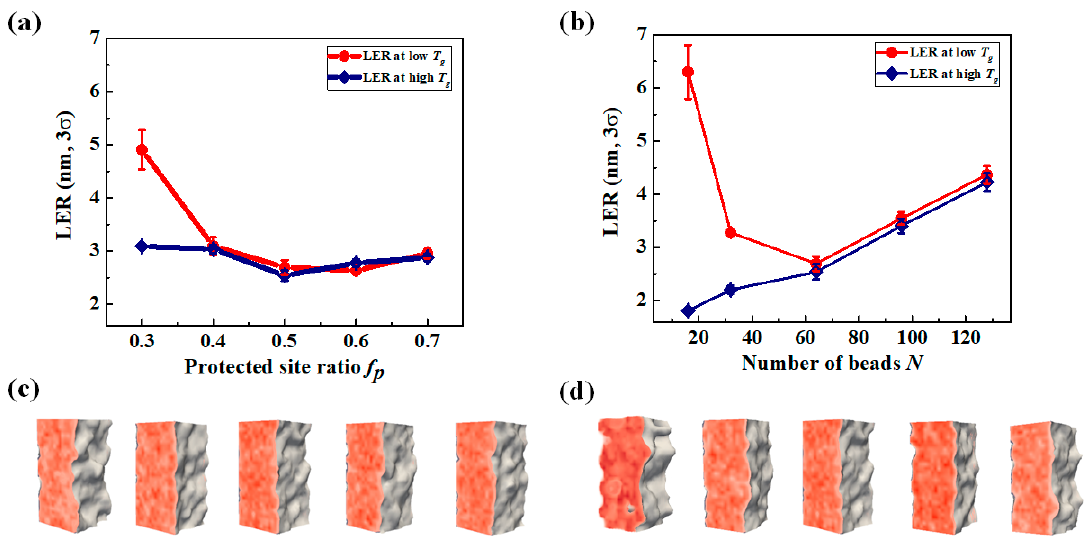
Figure 6. Line-edge roughness (LER) values after the entire CAR patterning process in low T g and high T g ; ( a ) LER as a function of the protected site ratio f p at fixed N = 64, ( b ) LER as a function of the number of beads N at fixed f p = 0.5, ( c ) 3D image of residual polymer from ( a ) for low T g resist, and ( d ) 3D image of residual polymer from ( b ) for low T g resist. In ( c ) and ( d ), red color map and gray contour curve are used to present the variation in the local density of residual resists on cross-cuts and the shapes of line edges, respectively.